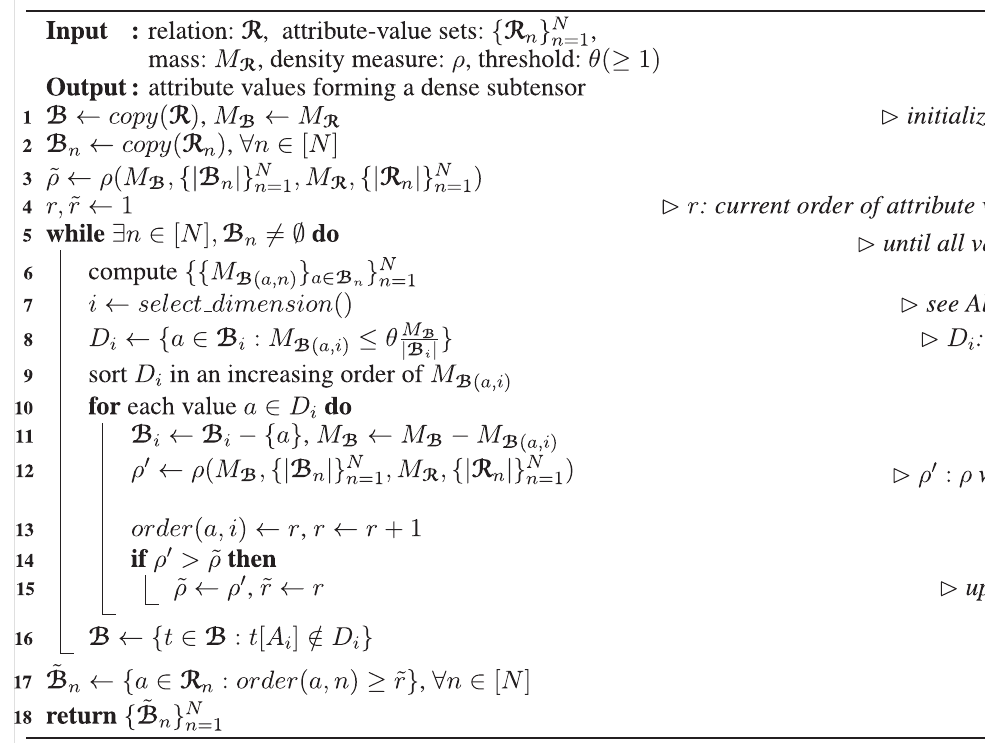
Algorithm 2 | fi nd _ one in